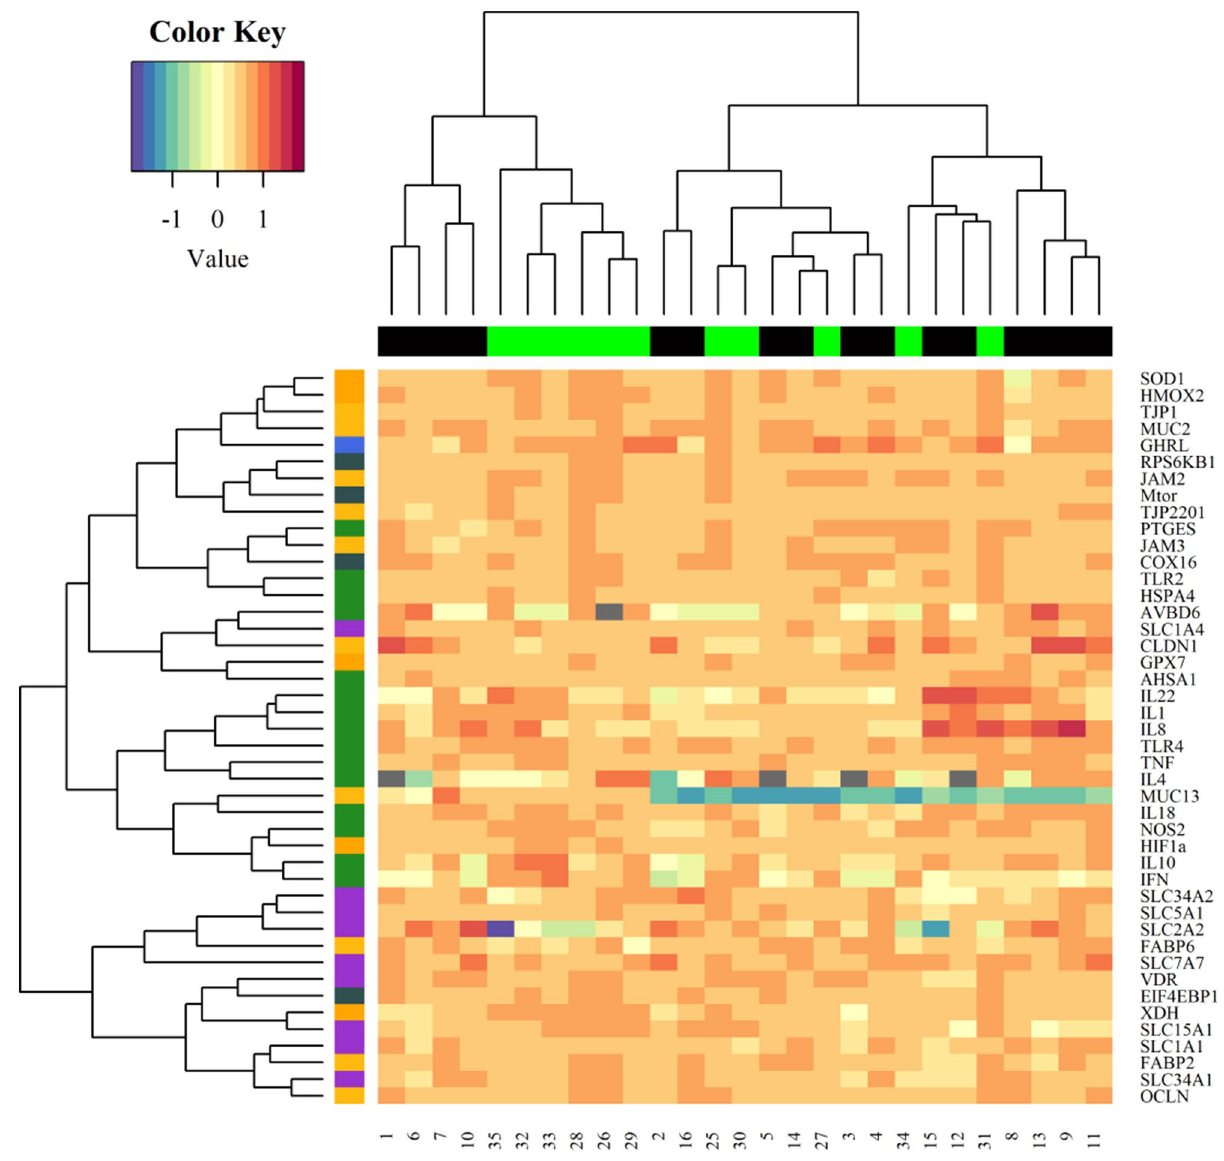
Figure 4. Heat map. The X-axis is sample expression pattern in different treatment group (black colour: before Eimeria challenge; green colour: after Eimeria challenge). The Y-axis is the gene clusters according to